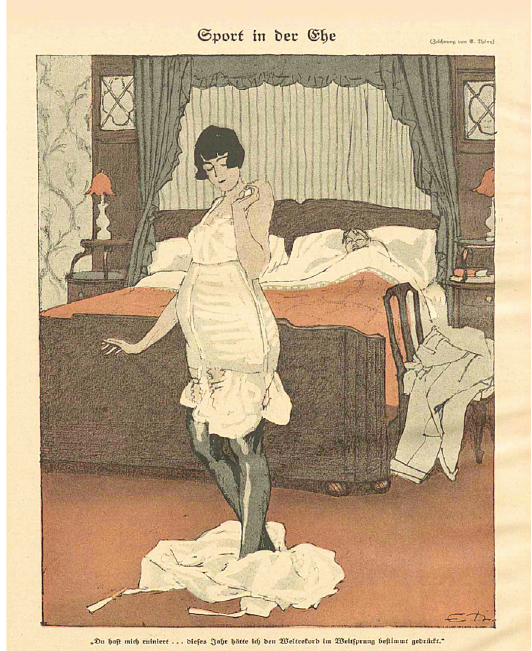
Figure 22. ‘Sport in Marriage’, Simplicissimus , 29 (1924), 372. ‘You have ruined me…. This year, I surely would have beaten the world record in the long jump.’ Image courtesy of Herzogin Anna Amalia Bibliothek Weimar. With permission of Dr. Dagmar von Kessel,